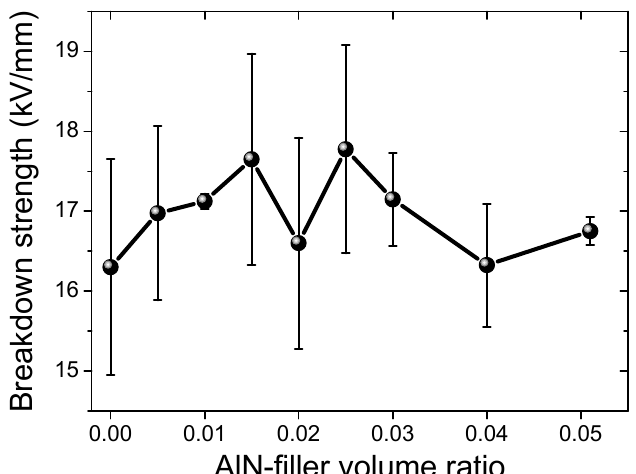
Figure 6. Electrical breakdown strength of the AlN-filled silicon rubber samples.